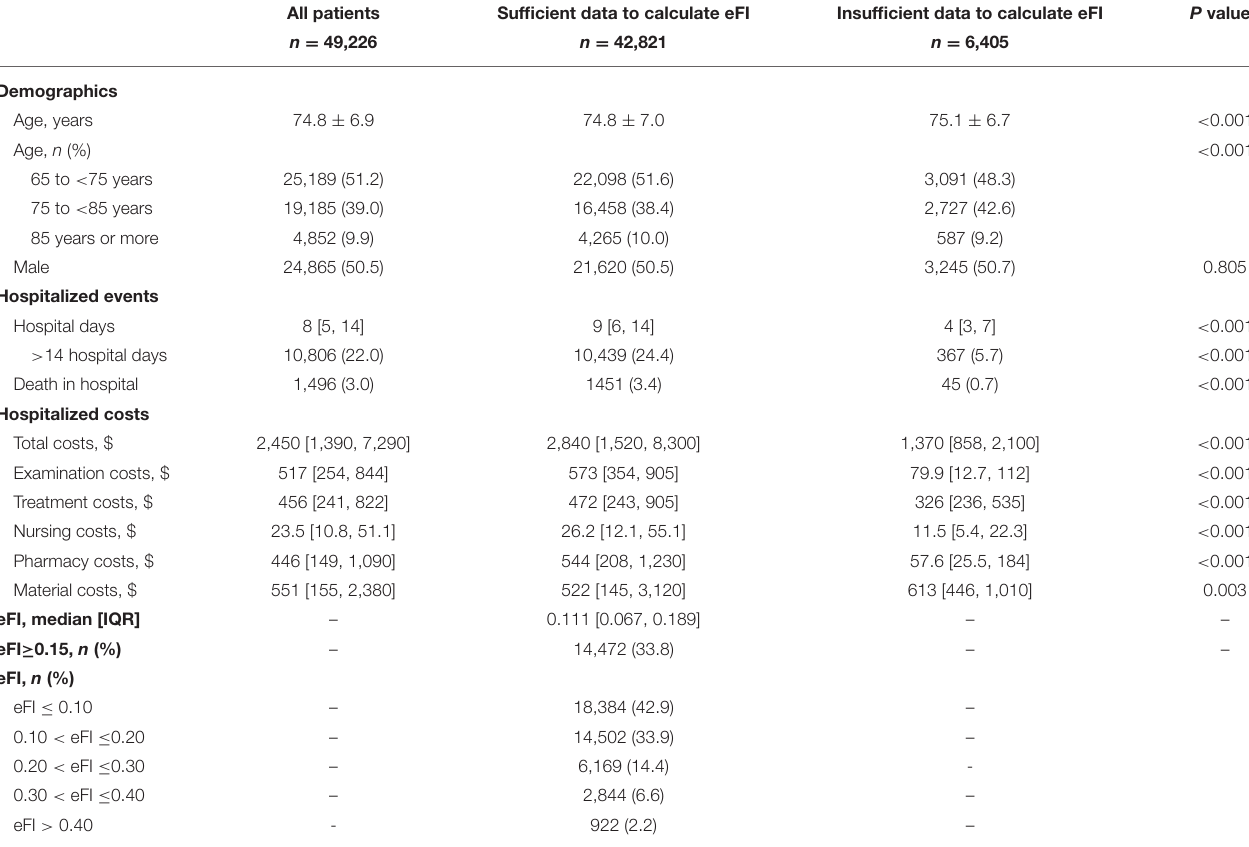
TABLE 1 | Demographics and hospitalized events and costs of all patients stratified by whether or not the eFI could be calculated from the electronic health records. All patients Sufficient data to calculate eFI Insufficient data to calculate